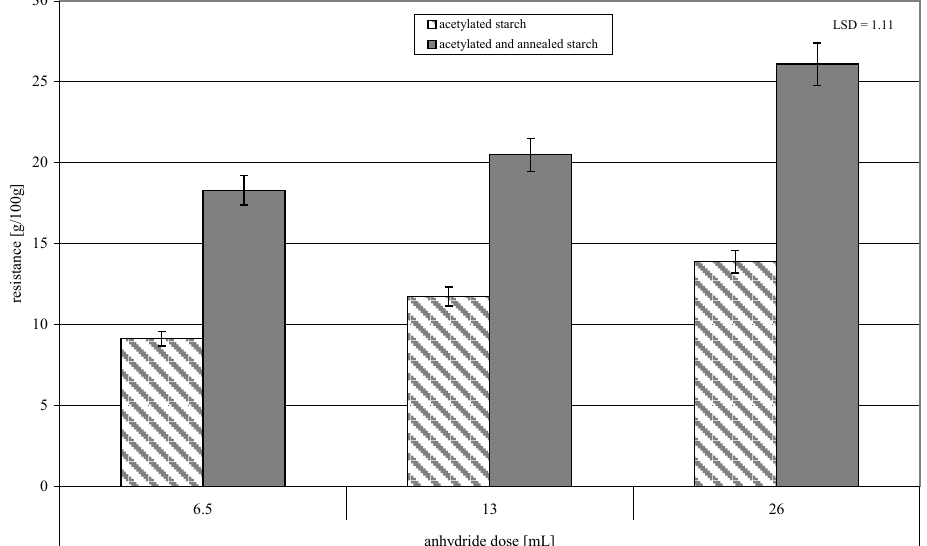
Figure 6. Resistance to amylolysis of preparations of acetylated starch and of acetylated and an- nealed starch.